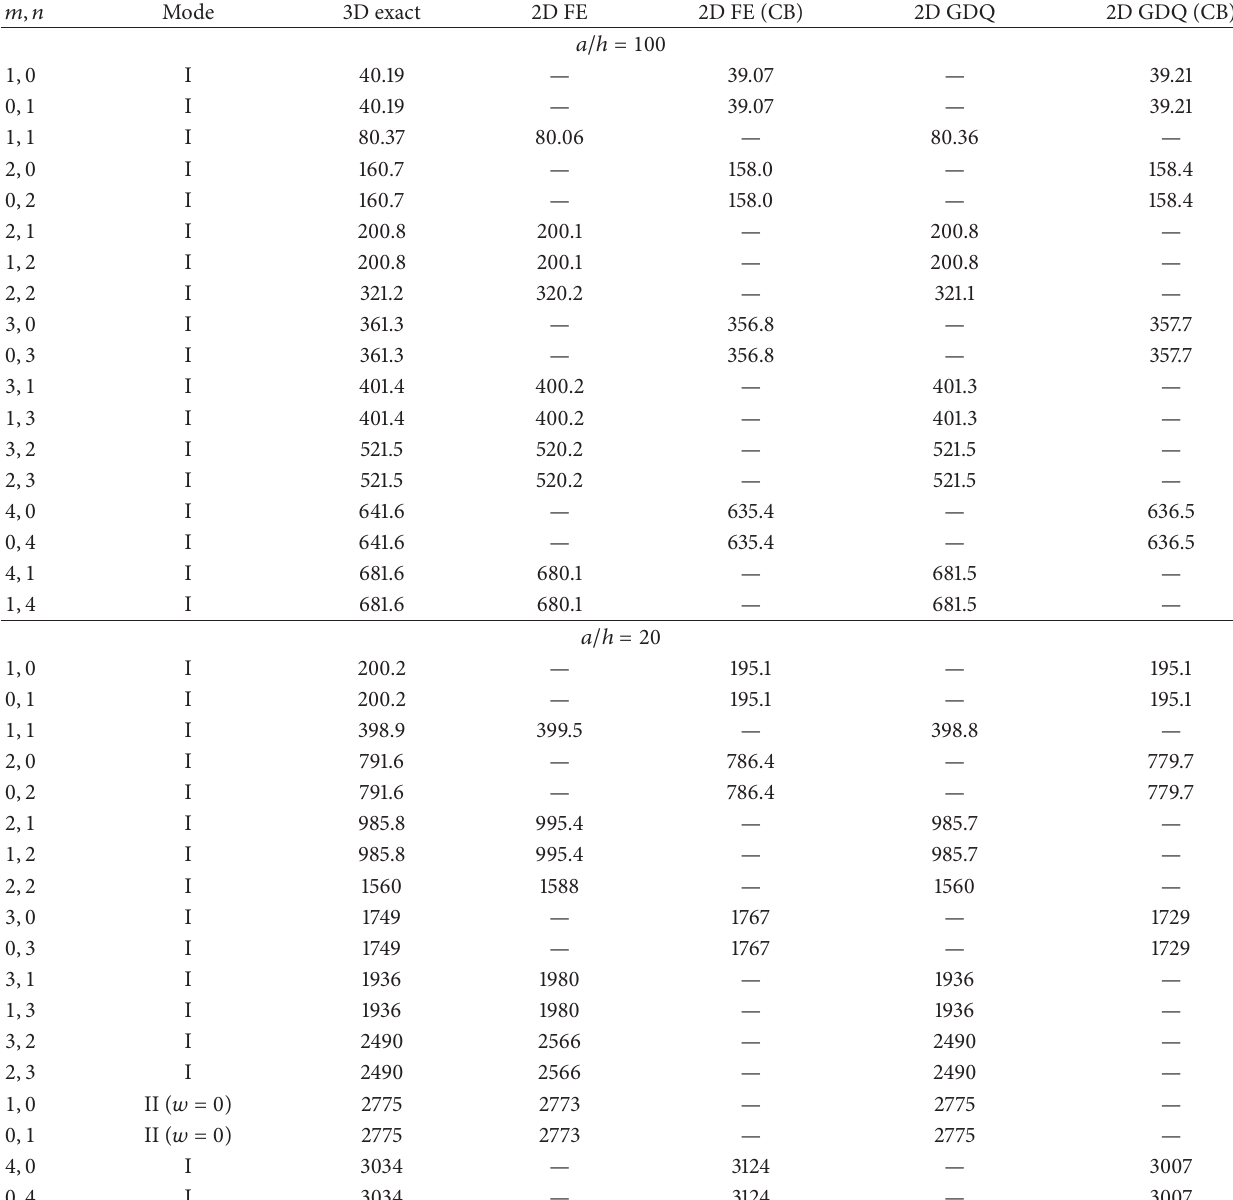
Table 1: One-layered FGM plate with 𝑝 = 0.5 . Analytical 3D versus 2D numerical models. Frequency 𝑓 in